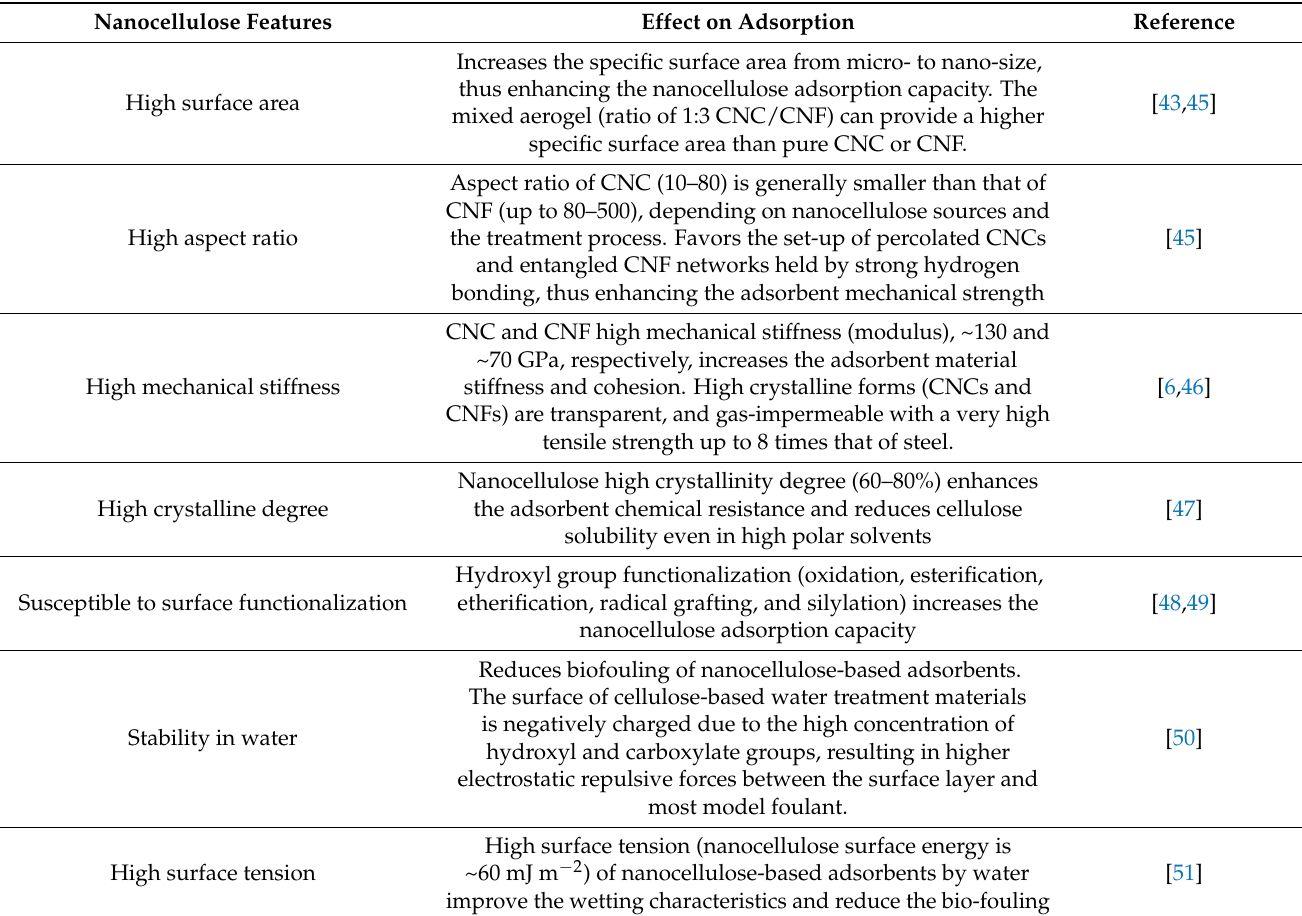
Table 2. Relation between the physicochemical features of nanocelluloses and their adsorption capacity for hazardous pollutants in the aqueous